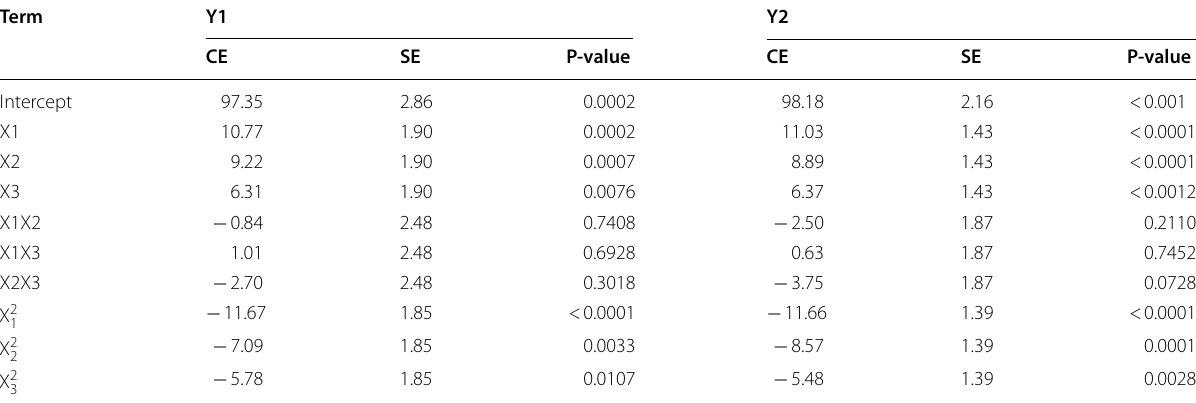
Table 4 Statistical analysis of model terms by multiple regression